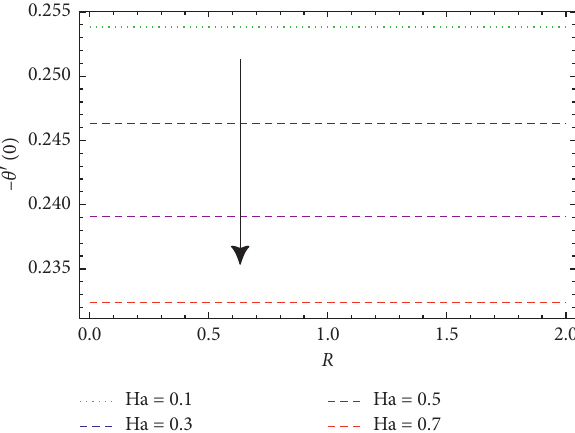
Figure 18: Nusselt number via R for different values of Ha.